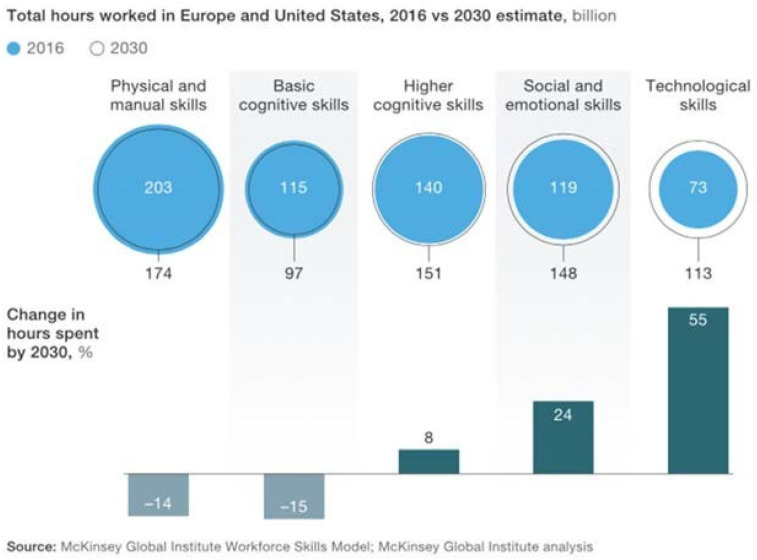
Skill shift caused by automation and AI (Bughin et al., 2018).